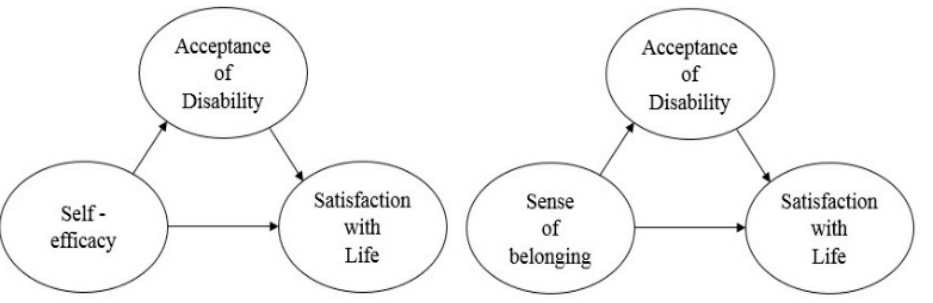
Figure 1. Conceptual model of study.